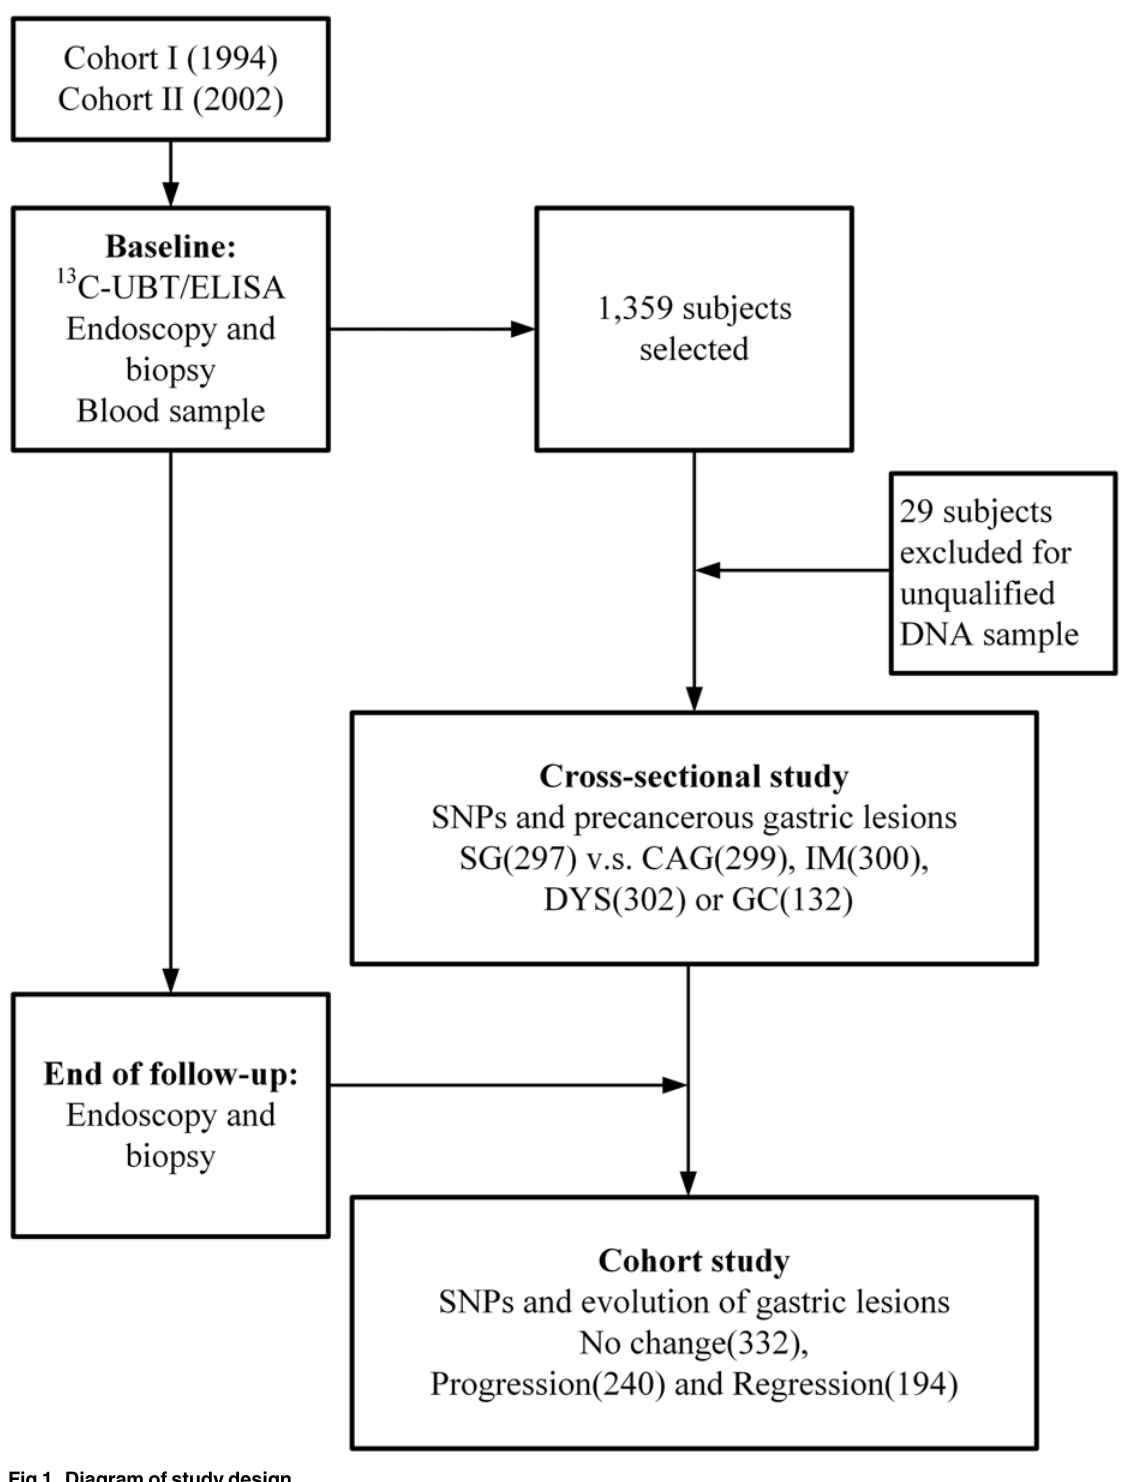
Fig 1. Diagram of study design.